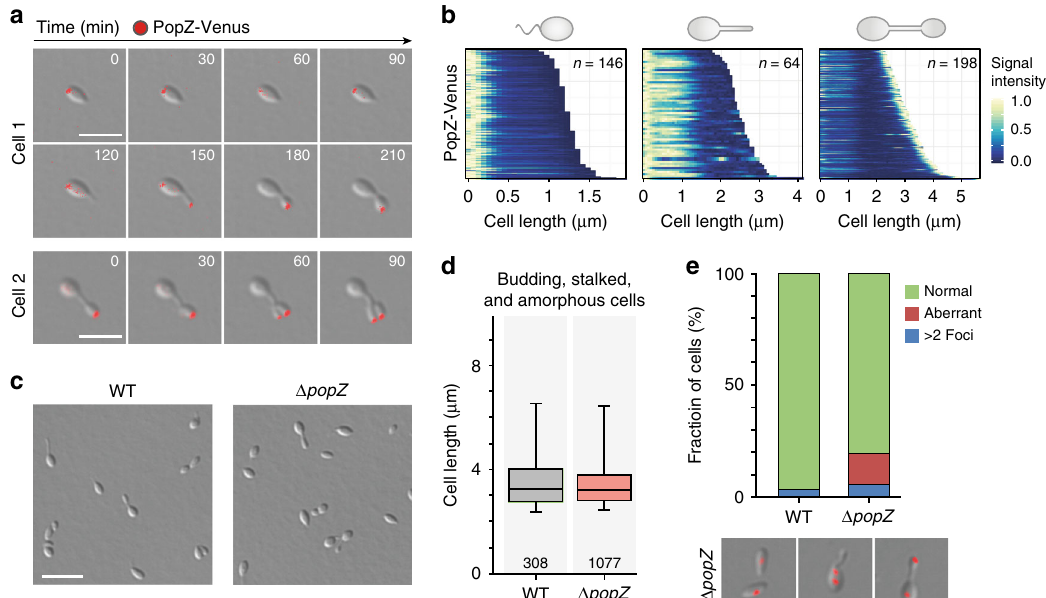
Fig. 6 Role of PopZ in chromosome organization. a Time-lapse series showing the localization of PopZ-Venus at different stages of the cell cycle. Cells of strain AJ34 (P Zn ::P Zn - popZ-venus ) were grown in MB medium, induced for 2.5 h with 0.5 mM ZnSO 4 , transferred to an MB-agarose pad, and imaged at regular intervals. Shown are overlays of DIC and fl uorescence micrographs. Bar 3 µ m. b Demographic representation of PopZ-Venus localization in swarmer (left), stalked (middle), and budding (right) cells of strain AJ34 (P Zn ::P Zn - popZ-venus ) grown as described in ( a ). c Phenotype of a Δ popZ mutant. Cells of strain AJ38 ( Δ popZ ) and the H. neptunium wild type were grown in MB medium and visualized by DIC microscopy. Bar: 5 µ m. d Distribution of cell lengths in the cultures described in ( c ). The data are represented as box plots. The horizontal line indicates the median, the box the interquartile range, and the whiskers the 5th and 95th percentiles. The number of cells analyzed is given underneath the boxes. Source data are provided as a Source Data fi le. e Comparison of ParB-YFP localization in wild-type and Δ popZ cells. Cells of strains AR48 ( parB-yfp ) and AJ89 ( Δ popZ parB-yfp ) were grown in MB medium and analyzed by DIC and fl uorescence microscopy. The graphs show the proportion of cells with abnormal ParB-YFP localization patterns ( n = 534 cells for AR48 and 612 cells for AJ89). Source data are provided as a Source Data fi le. The micrographs at the bottom give examples of the different categories quanti fi ed. Shown are overlays of DIC and fl uorescence micrographs. Bar: 3 µ m